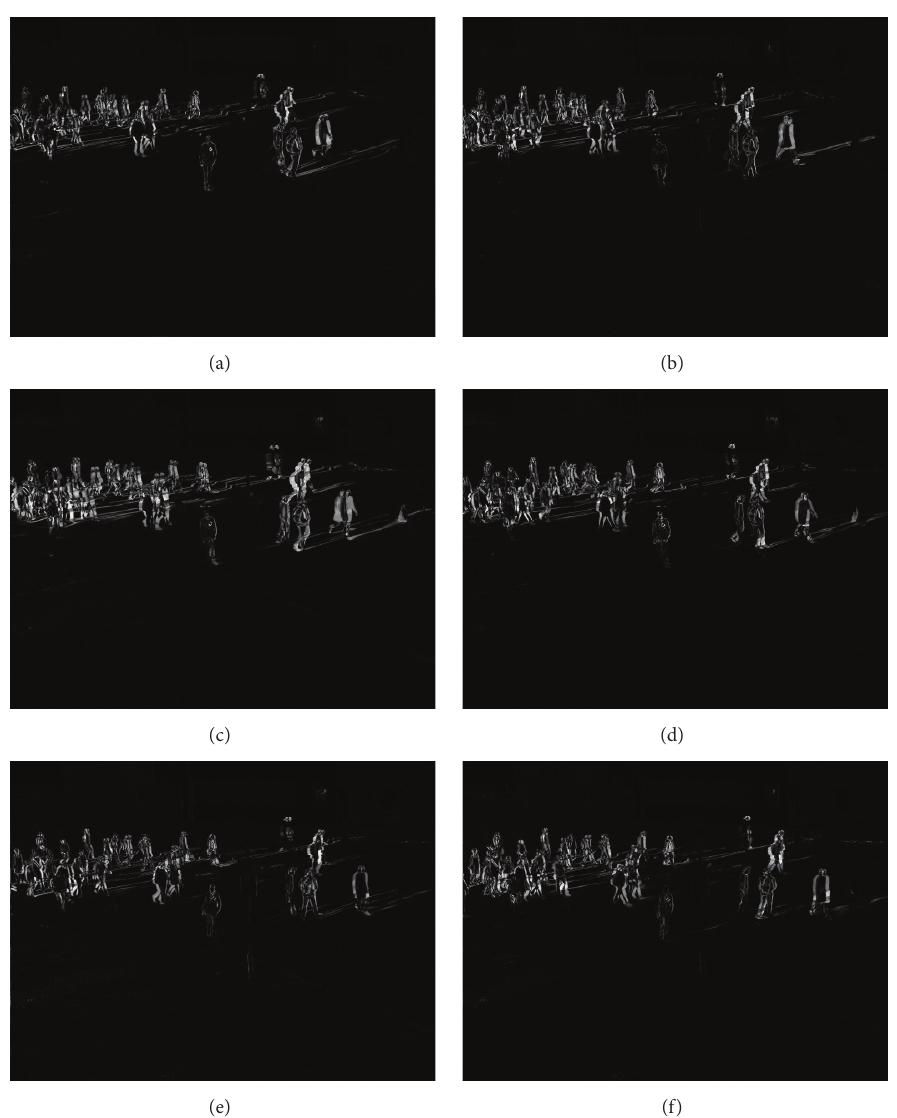
Figure12:PETSdatasetisusedformotiondetectionusingsurveillancecameras.Datasetusedinthisapplicationiscapturedusingstillcamera whereas objects are moving. The white area is showing that multiple persons are passing from this area. This application can be used to track if someone entered a place where entrance is not